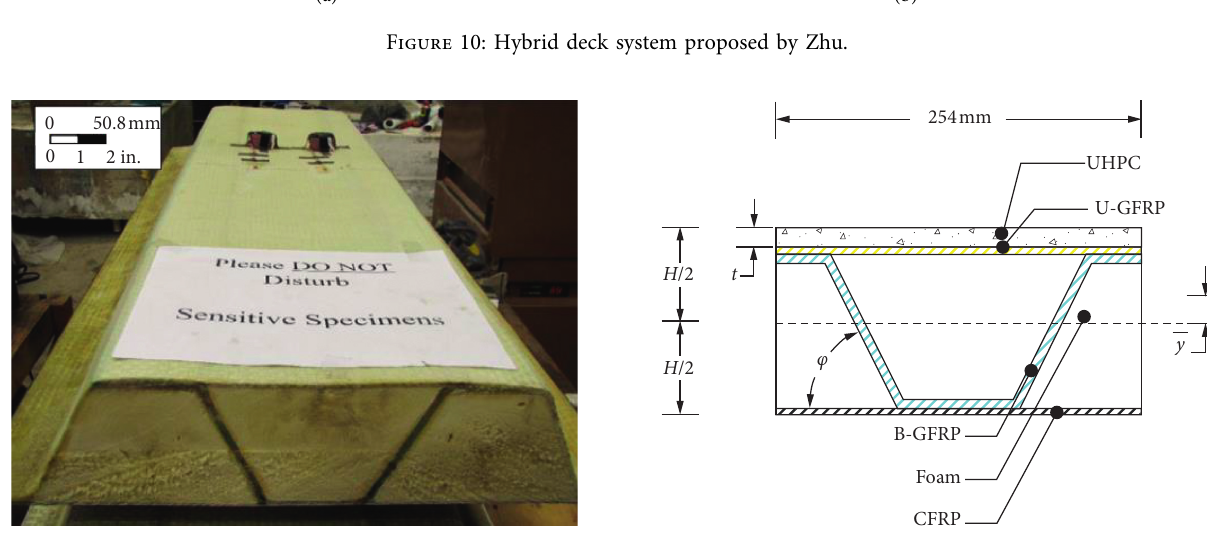
Figure 11: Hybrid deck system proposed by Tuwair. Figure